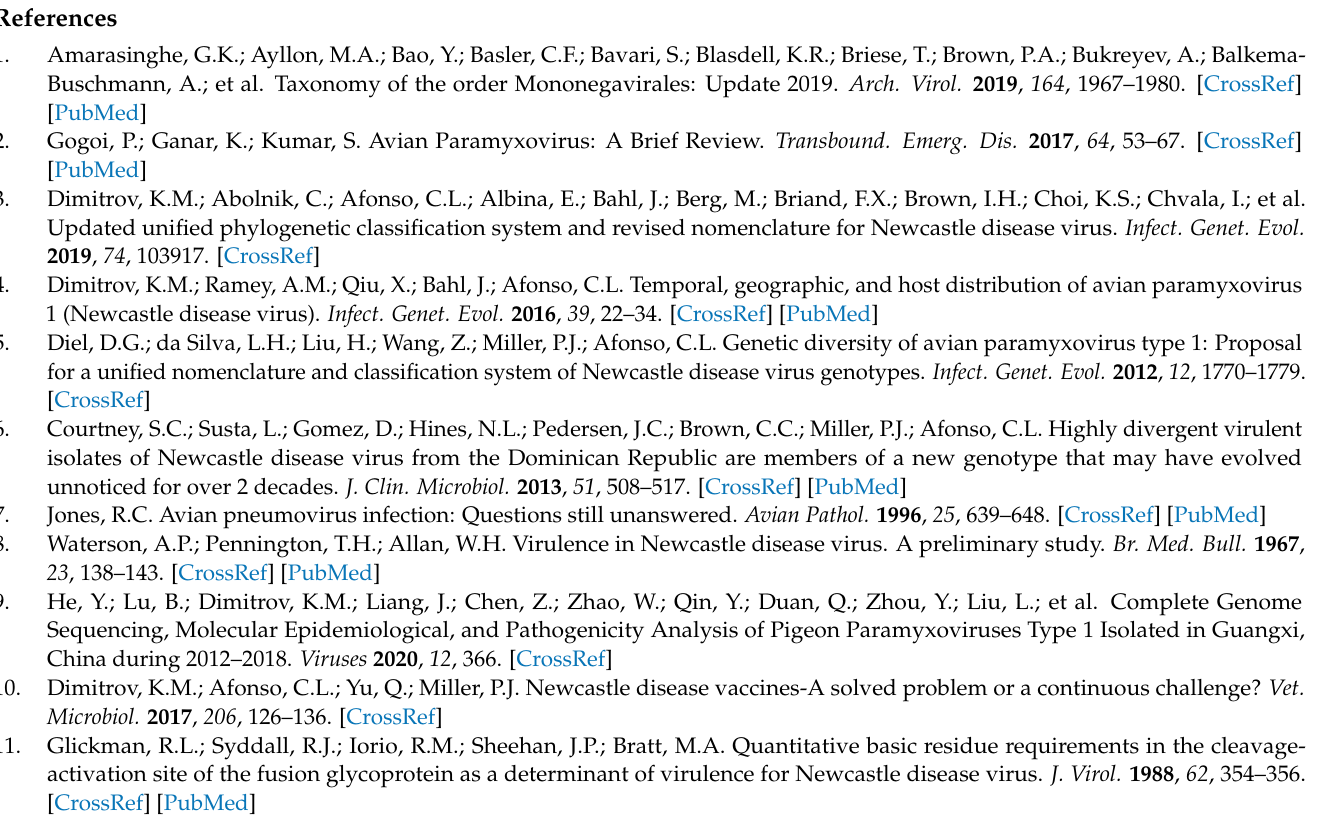
Table S1: Supplementary